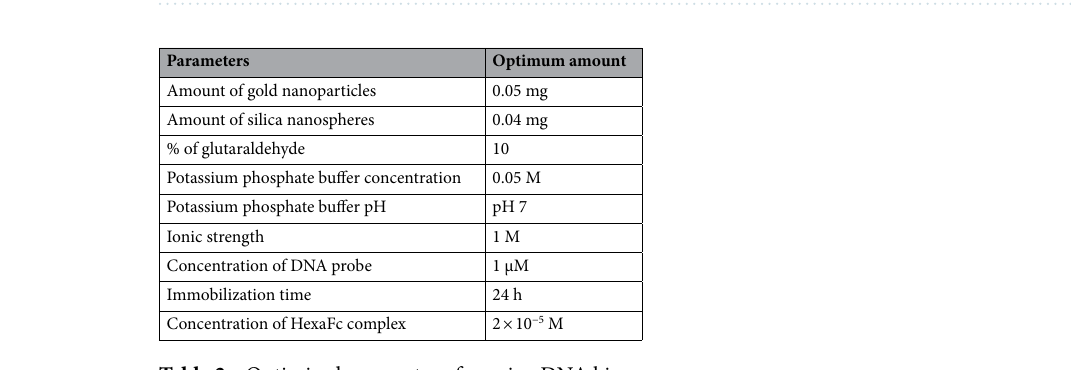
Table 2. Optimised parameter of porcine DNA